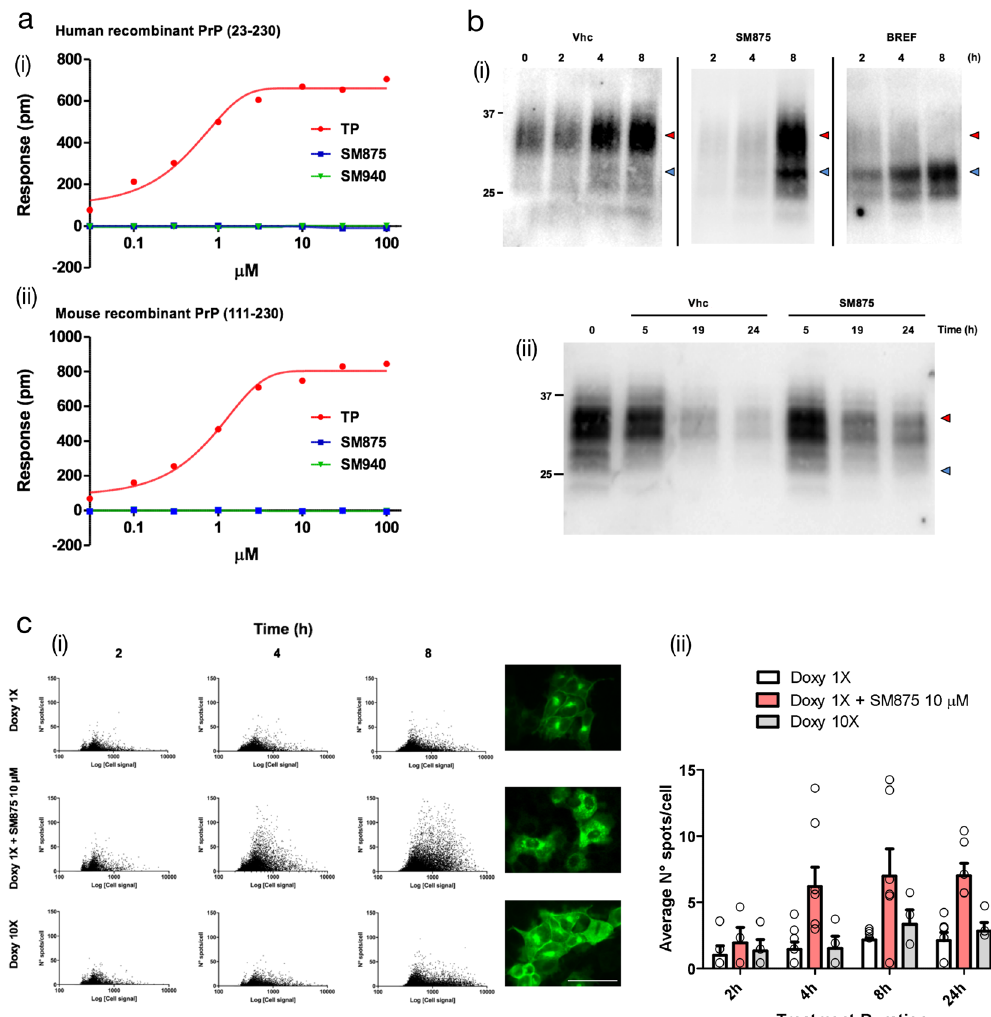
Fig. 5 SM875 acts exclusively on non-native, newly synthesized PrP. a DMR was employed to assess whether SM875 has an af fi nity for the native conformation of PrP. Different concentrations (0.03 – 100 μ M) of SM875, SM940 or PrP ligand Fe3 + -TMPyP (TP), used as a control, were added to label- free microplate well surfaces on which either (i) full-length, human recombinant PrP (23 – 230) or (ii) N-terminally deleted mouse recombinant PrP (111 – 230) had previously been immobilized. All signals were fi tted (continuous lines), when possible, to a sigmoidal function using a 4PL non-linear regression model. In contrast to SM875 and SM940, TP shows a detectable af fi nity for both full-length, human, and N-terminally deleted, mouse PrP molecules (for full-length PrP, K d = 0.67 ± 0.05, R 2 = 0.99). b In order to dissect the effect of SM875 on nascent vs mature, native PrP molecules, we turned to RK13 cells expressing mouse PrP under control a doxycycline-inducible promoter. (i) PrP expression was induced over 8 h, in the presence of SM875 (10 μ M), brefeldin-1A (BREF, 10 μ M), or vehicle (Vhc) control, samples were collected at different time points (indicated) and PrP signals were visualized by western blotting. Signals were detected by probing membrane blots with anti-PrP antibody (D18). As expected, in control cells, the level of full-length PrP (red arrowheads) increases in a time-dependent fashion. Conversely, a lower molecular weight band (blue arrowheads) is detected in brefeldin-treated cells. (ii) Next, we designed an experiment to test the effect of SM875 exclusively on mature, natively folded PrP. PrP expression was induced for 24 h, in the absence of any additional treatment. Doxycycline was then removed, and after 4 h without inducer, the cells were exposed to SM875 or Vhc control, and subsequently lysed at different time points (indicated). In this experimental setting, cells are exposed to SM875 only when all PrP molecules are synthesized and likely in transit to, or already reached the plasma membrane. In these conditions, normal PrP patterns appear in both compound-treated and Vhc-treated cells. c A high-content approach was employed to the same experimental setting described above by analyzing the localization of PrP after immunostaining with an anti-PrP antibody (D18) coupled to an Alexa 488 secondary antibody. (i) The expression of PrP was induced for 2, 4, or 8 h by doxycycline 1× (0.01 mg/mL) or 10× (0.1 mg/mL) and the effect of SM875 (10 μ M) incubated with doxycycline 1× was measured by Harmony software after the image acquisition performed by Operetta Imaging System. Green spots detected in cells were quanti fi ed and plotted against the total green fl uorescence relative to each cell. Representative images were acquired at 8 h of incubation, scale bar 50 μ m. (ii) Quanti fi cation of the average number of green spots per cell in wells incubated for 2, 4, 8, and 24 h with doxycycline 1× (white bars), doxycycline 10× (gray bars) and doxycycline 1× + SM875 (red bars). Quanti fi cation of at least three independent